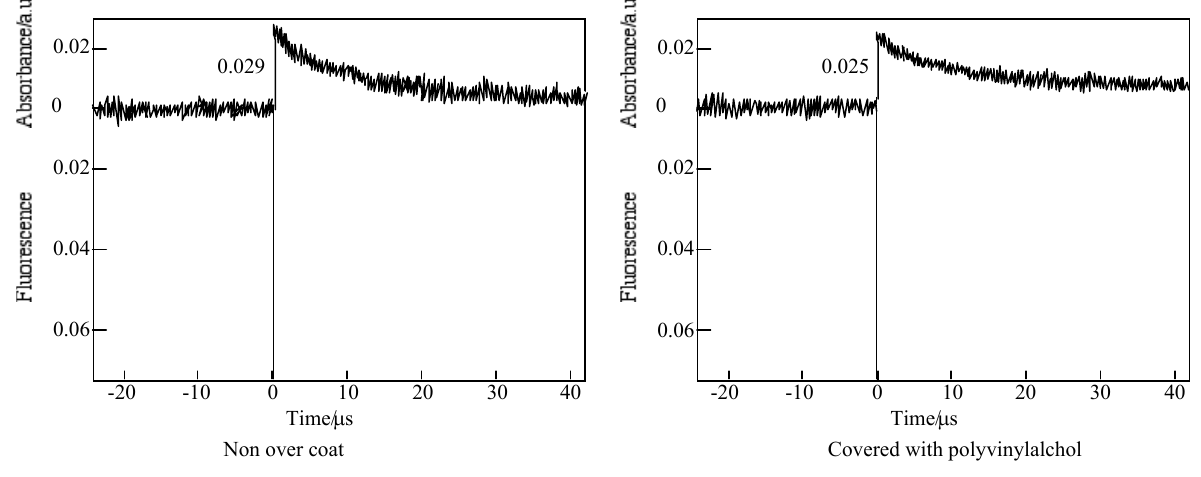
Figure 16. Decay trace of 5c in PMMA film on 560 nm. Excitation wavelength: 355 nm in the presence and absence of PVA over